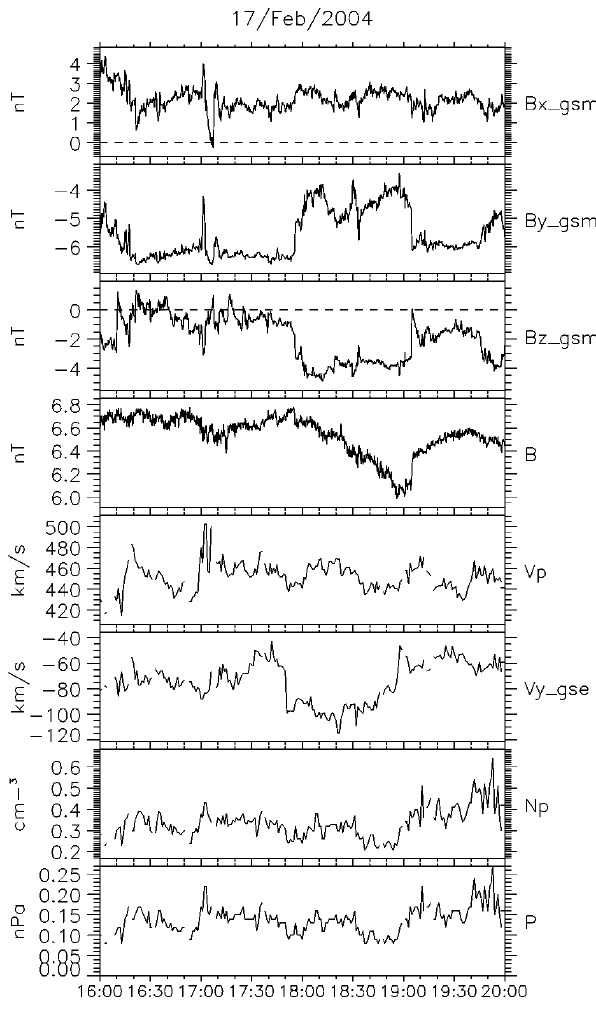
Fig. 1. 17 February 2004. From top to bottom: B X , B Y and B Z IMF components in the GSM frame as measured by